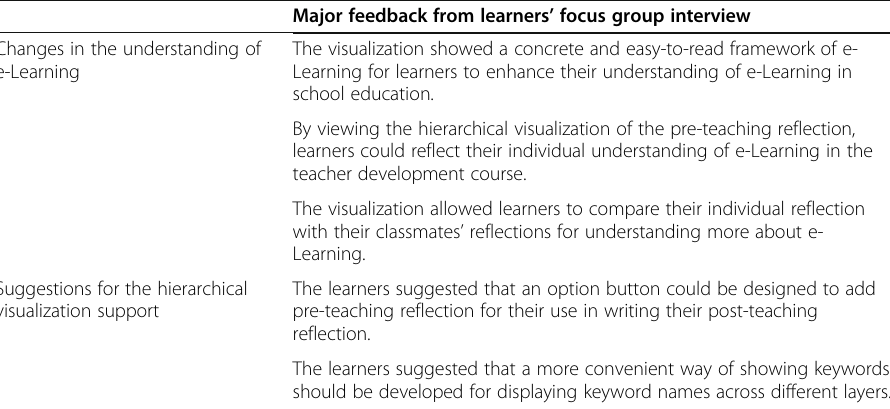
Table 8 Focus group interview results of learners ’ perception of the e-Learning framework with the support of computer-aided analysis and hierarchical